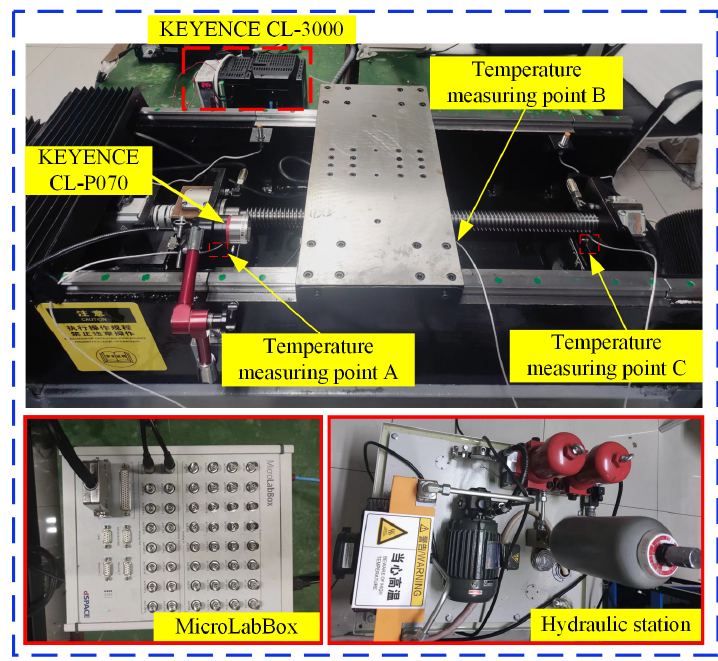
Figure 10. Experimental setup of